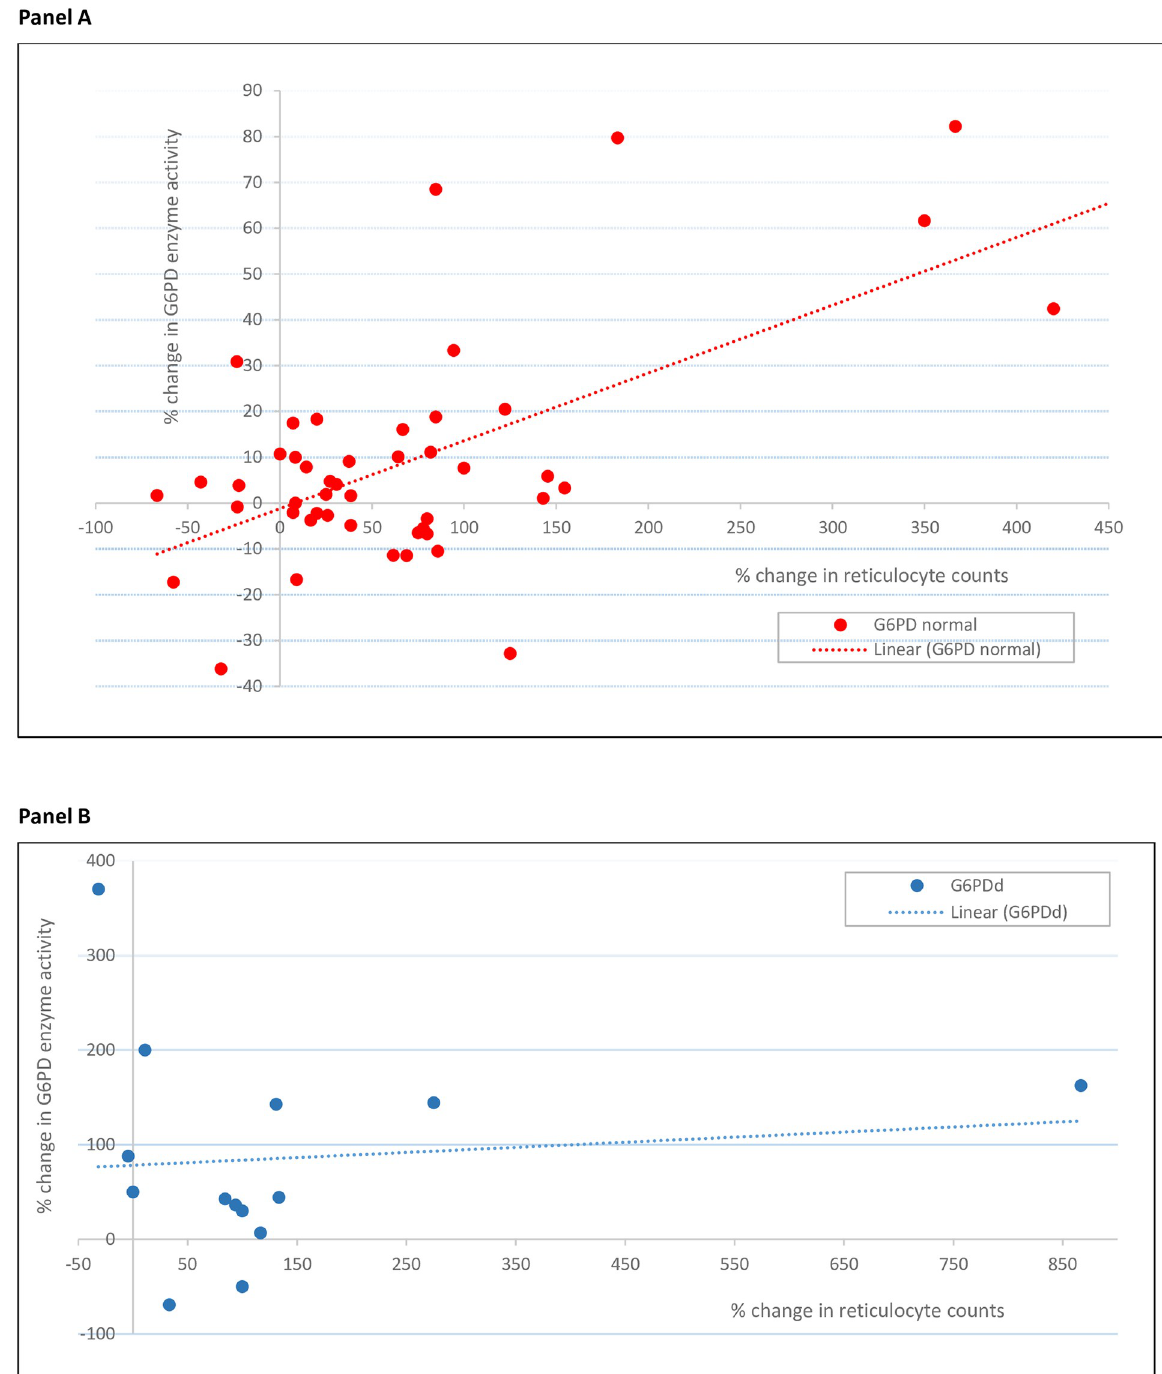
Fig 3. Relationship between the percentage changes in G6PD activity and percentage changes in reticulocyte counts between Day 7 and baseline in the two G6PD groups. Panel A: G6PD normal patients: the Pearson correlation coefficient, r, was 0.14, adjusted R 2 0.34 (p < 0.001). Panel B: G6PD deficient patients: r = 0.063, aR 2 = -0.063 (p = 0.64).